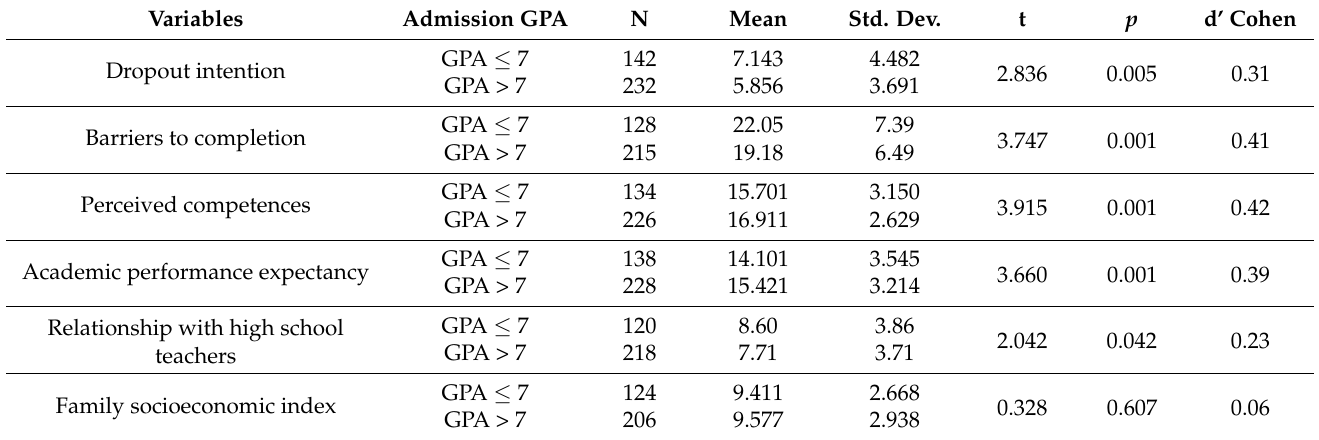
Table 5. Differences regarding students’ admission GPA